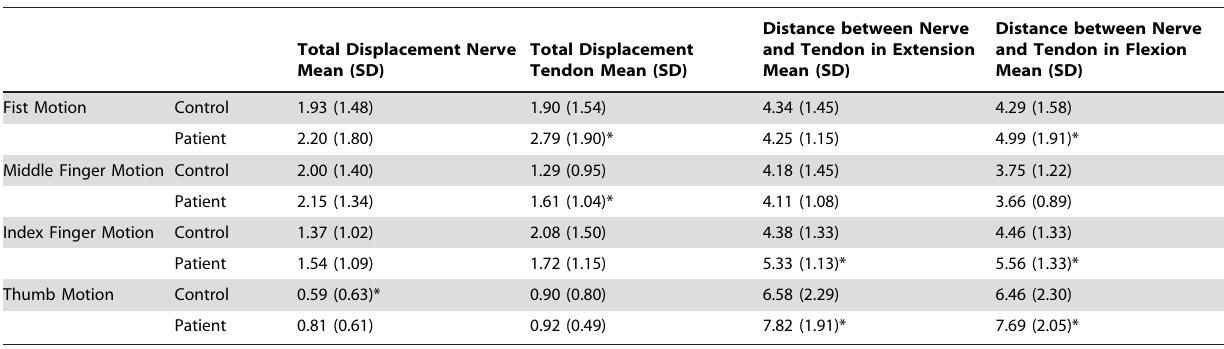
Table 2 . Displacement and distance between median nerve an flexor tendons.